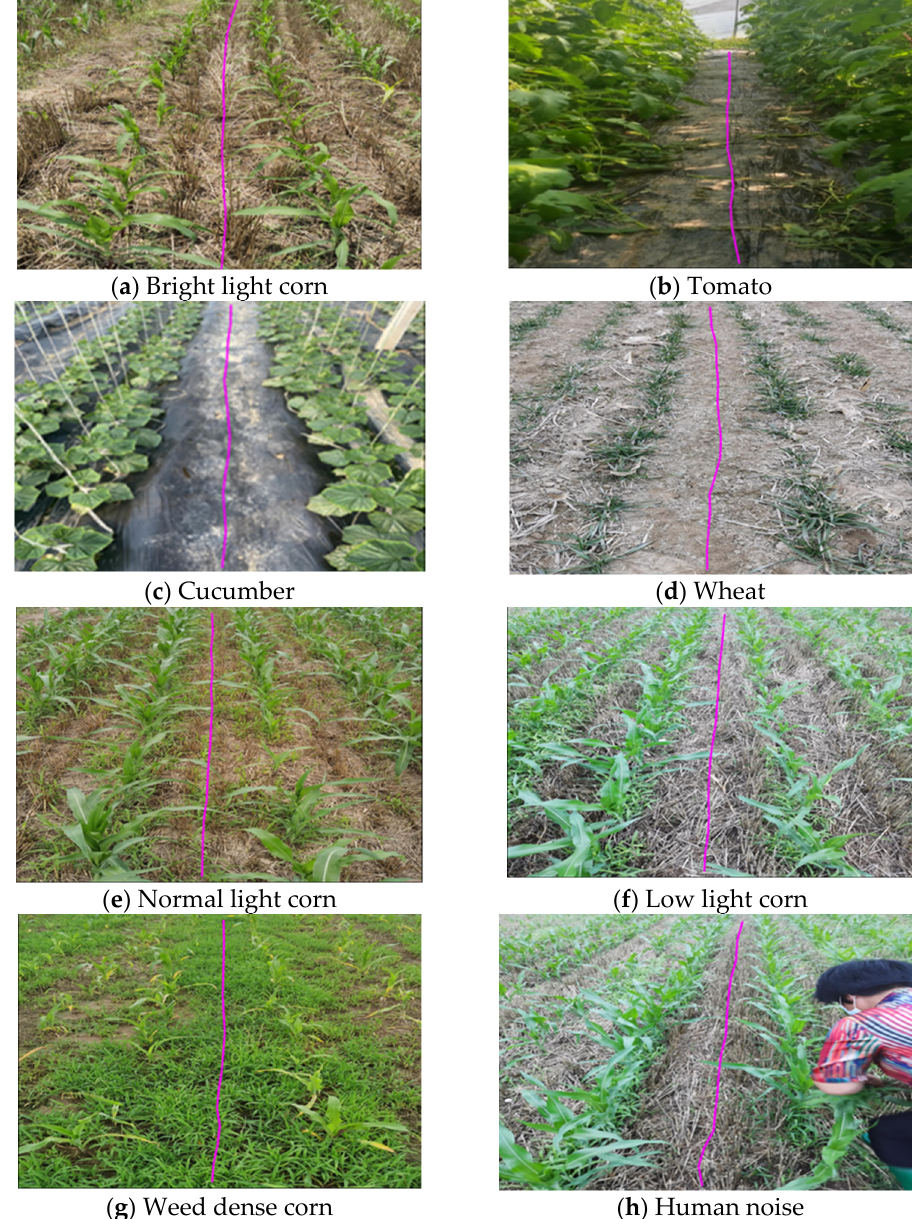
Figure 14. Extraction results of navigation line based on B-spline curve.